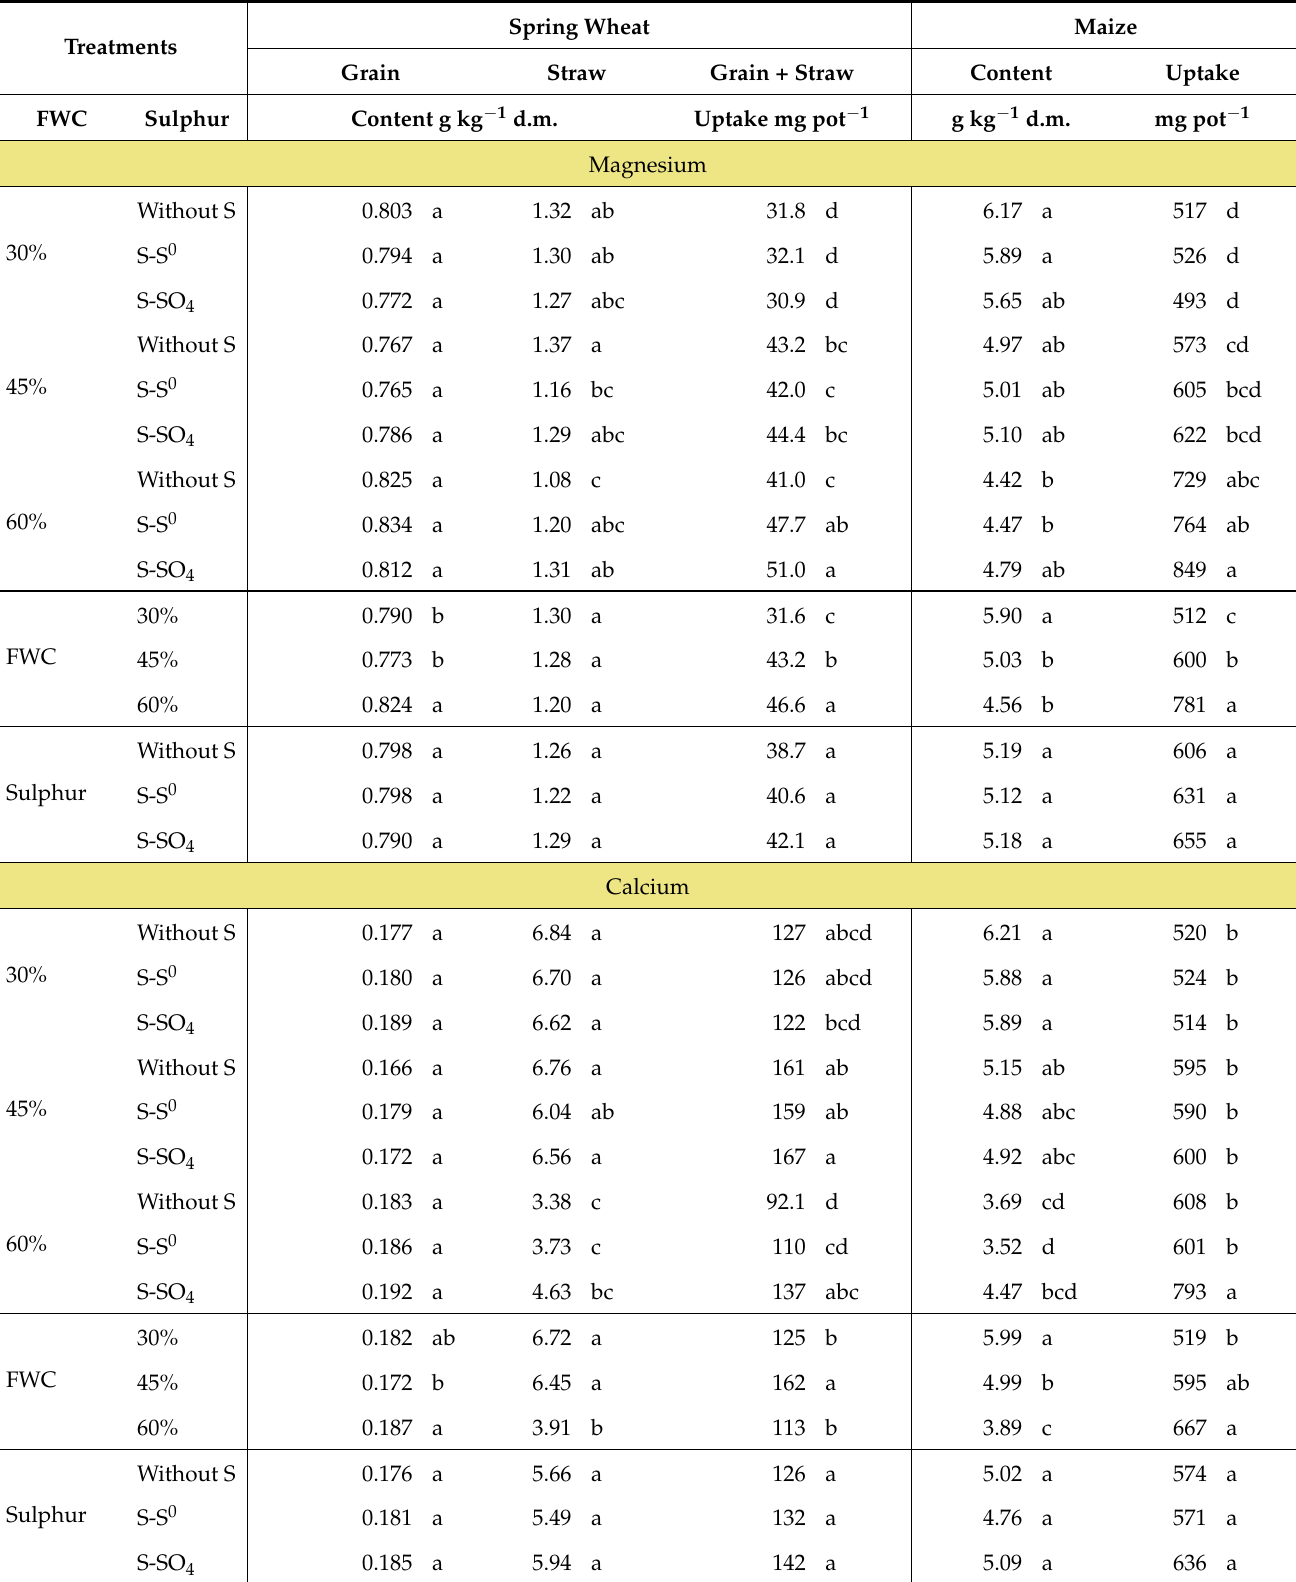
Table 5. Magnesium and calcium content and uptake in cultivated plants. Values indicated by the same letter are not significantly different ( α =